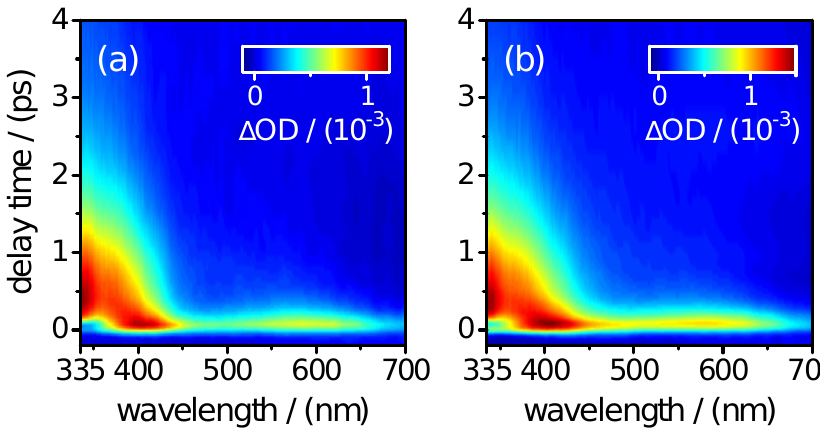
Figure 4. Two-dimensional maps of the observed changes in optical density in the transient absorption experiments on XMP after excitation at: ( a ) λ pump = 260 nm; and ( b ) λ pump = 243 nm.